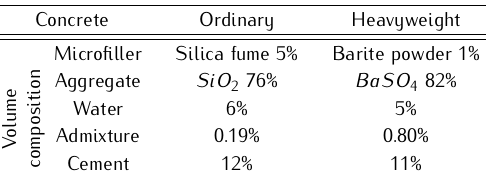
Table 7. Atomic composition of ordinary and heavyweight concrete for MCNPX and SPOT